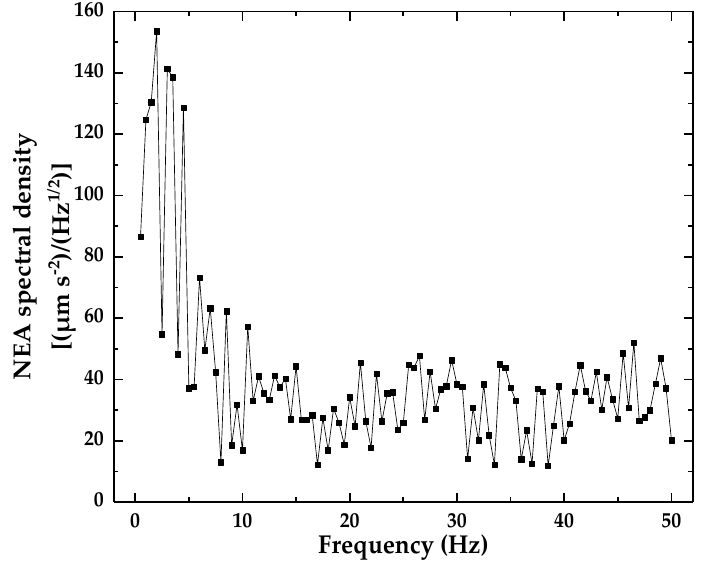
Figure 13. Noise equivalent acceleration (NEA) spectral density.